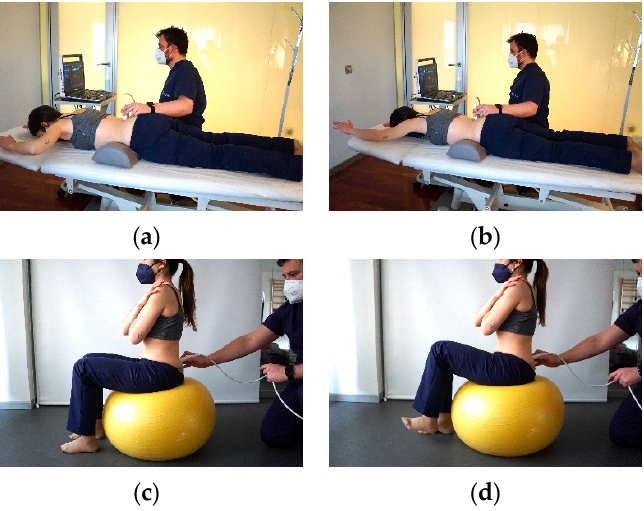
Figure 2. Images representing the positions used to measure LM muscle thickness at rest and contraction in different positions to obtain the CR ( a ) Lumbar multifidus (LM) thickness measurement in prone at rest, ( b ) LM thickness measurement in prone in contraction with arm elevation, ( c ) LM thickness measurement at rest on Fitball, ( d ) LM thickness measurement in contraction on itball with leg elevation.